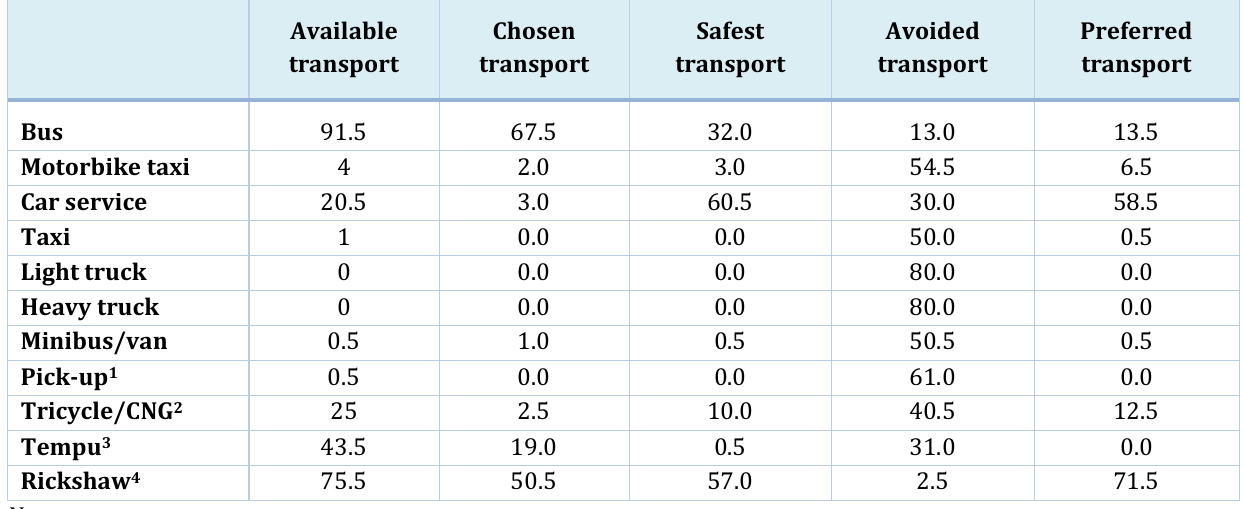
Table 2. Transport types: Percentage reported availability, type chosen on day of interview, opinion of safety type, and types avoided and preferred ( n = 200). Multiple responses allowed